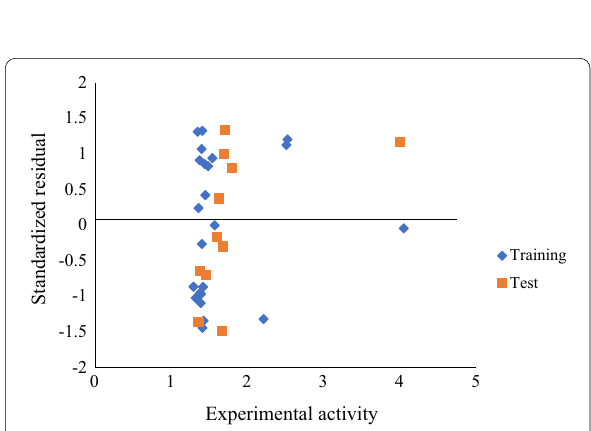
Fig. 3 The plot of standardized residual against experimental activity